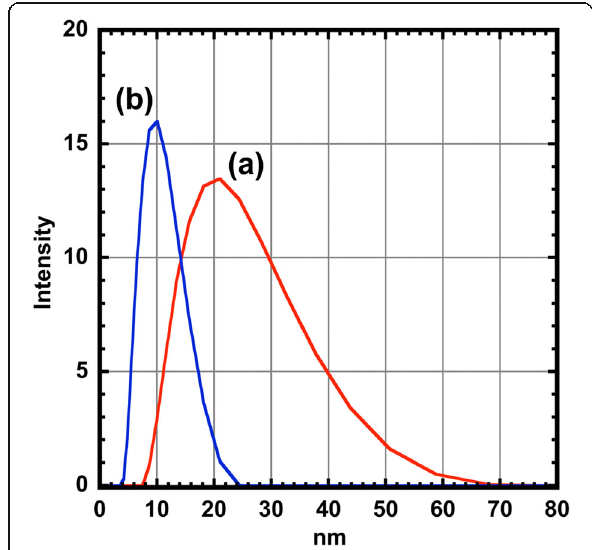
Fig. 6 Size distribution ( a ) of the CoFe 2 O 4 (red line) and ( b ) the CoFe 2 O 4 @Ag nanoparticles (blue line) measured by DLS